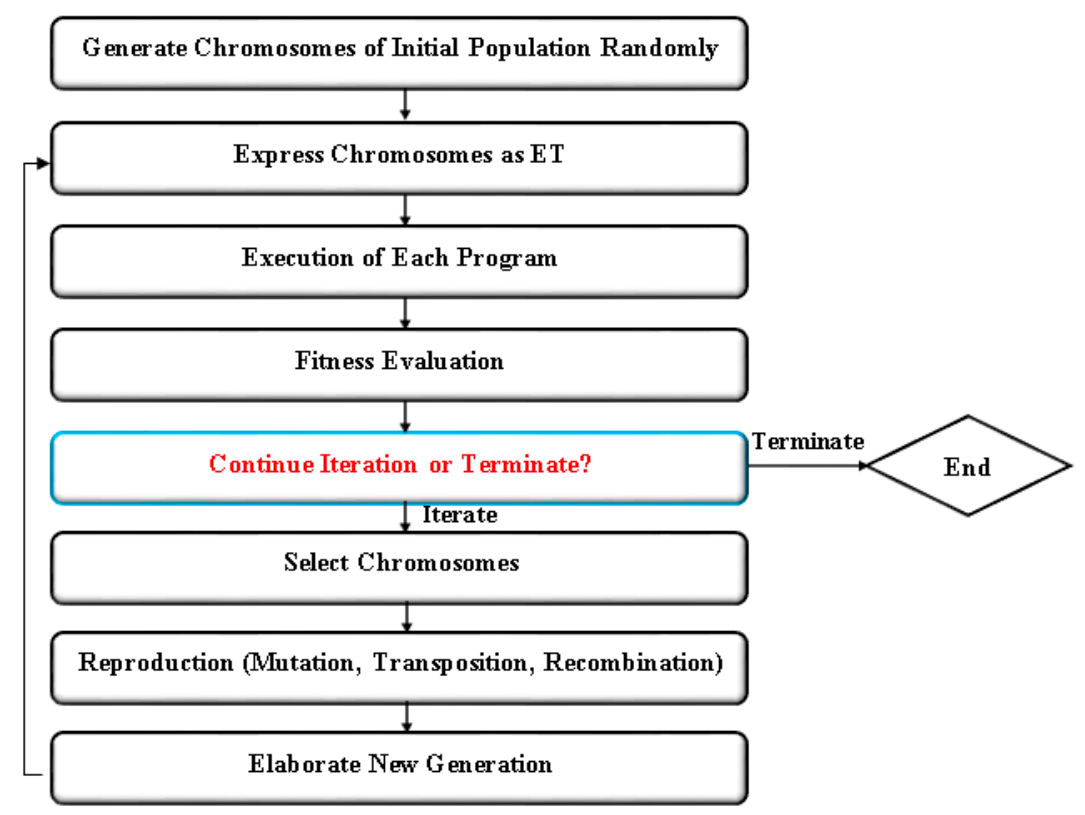
Figure 1. Flowchart of gene expression programming (GEP) algorithm procedure.